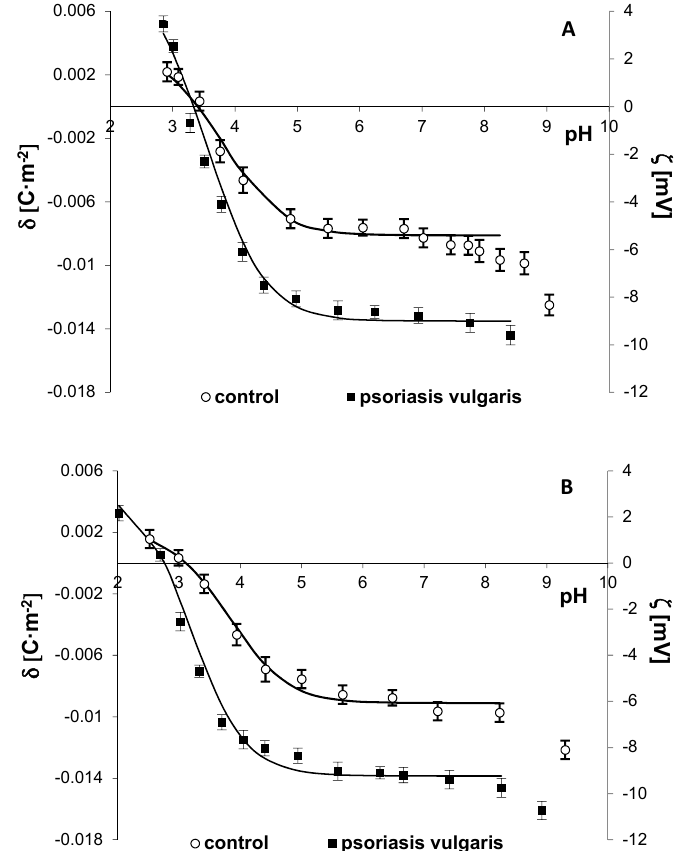
Figure 3. The surface charge density (left axis) and corresponding zeta potential (right axis) of keratinocyte ( A ) and fibroblasts ( B ) cell membrane of patients with psoriasis vulgaris ( n = 16) as well as healthy subjects ( n = 8). Data points represent the mean ± SD.